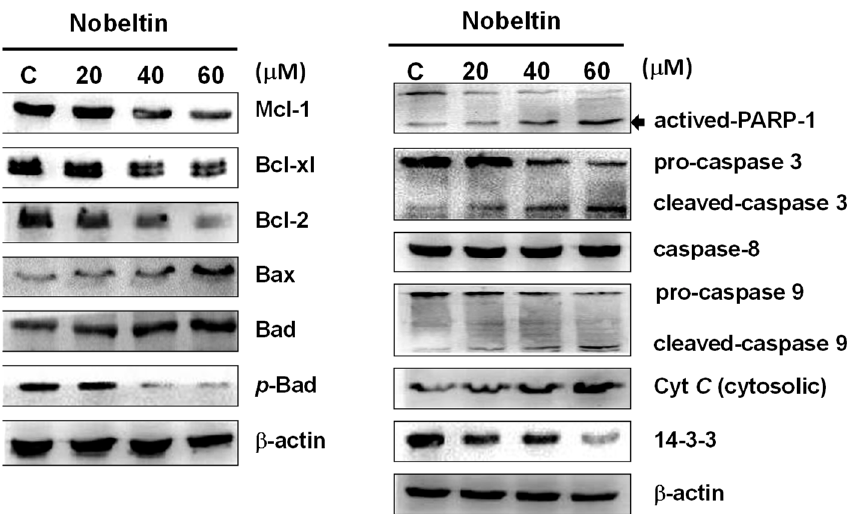
Figure 3. Western blot analysis of the expressions of proteins of the mitochondrial-mediated intrinsic pathway in NOB-treated BFTC bladder cancer cells. BFTC cells were treated with different concentrations of NOB (20–60 μ M) for 24 h. The protein lysates were subjected to western blot analysis with antibodies against Mcl-1, Bcl-xl, Bcl-2, p -Bad, Bax, Bad, PARP-1, pro-caspase-3, cleaved-caspase-3, pro-caspase-9, cleaved-caspase-9, caspase-8, cytochrome C , and 14-3-3 protein. β -actin was used as the loading control.